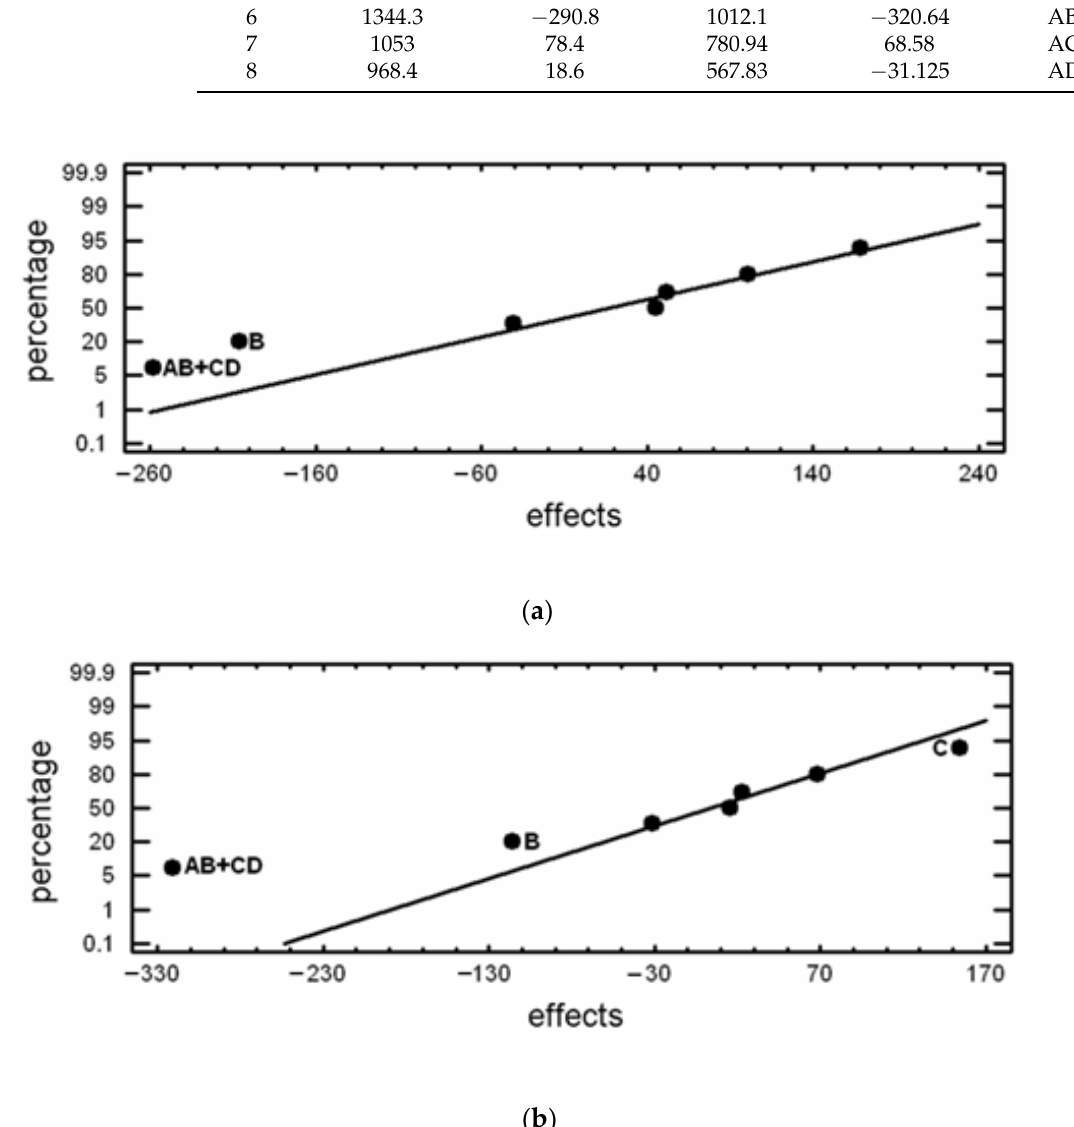
Figure 5. Normal probability plot showing the factors with significant effect on: ( a ) flexural strength to failure (MPa) and ( b ) absorbed energy to fracture (mJ).